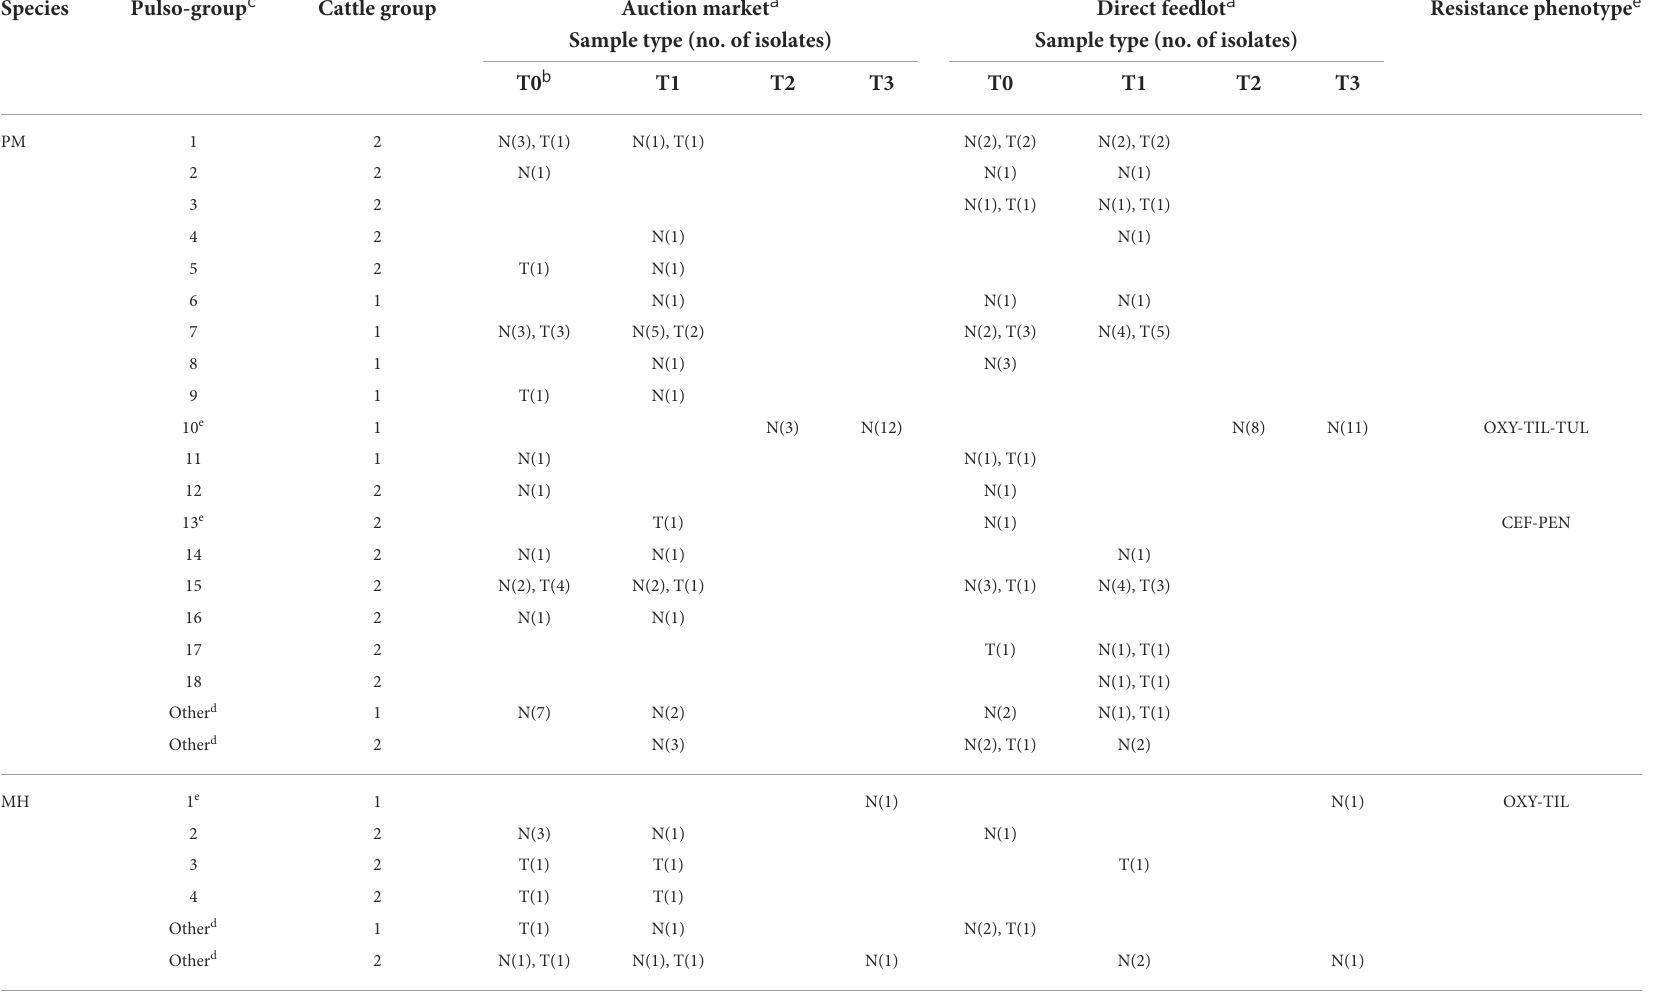
TABLE 1 Characterization of Pasteurella multocida (PM) , Mannheimia haemolytica (MH) , and Histophilus somni (HS) isolates from cattle sampled by deep nasal swab (N) or trans-tracheal aspiration (T).